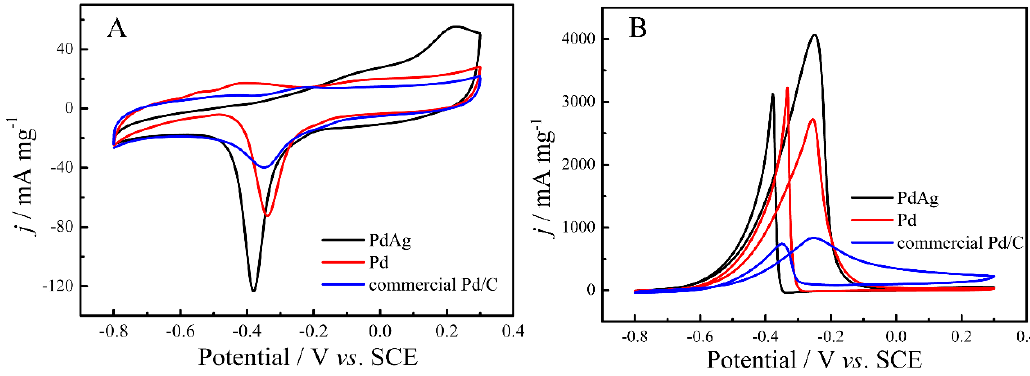
Figure 4. Cyclic voltammograms of the as-prepared PdAg, Pd and commercial Pd/C in ( A ) 1.0 M KOH;